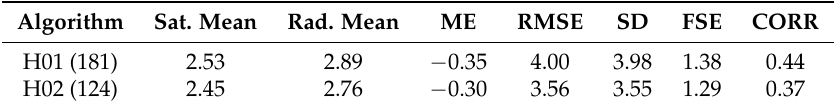
Table 6. Continuous scores for Vale do Paraíba for H01 and H02. The number inside parenthesis concerns the number of matched pixel pairs for each